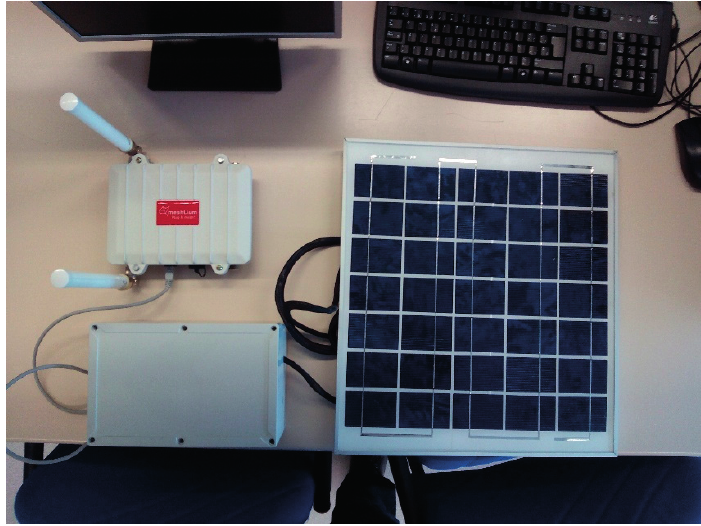
Figure 10. UIS Receiver